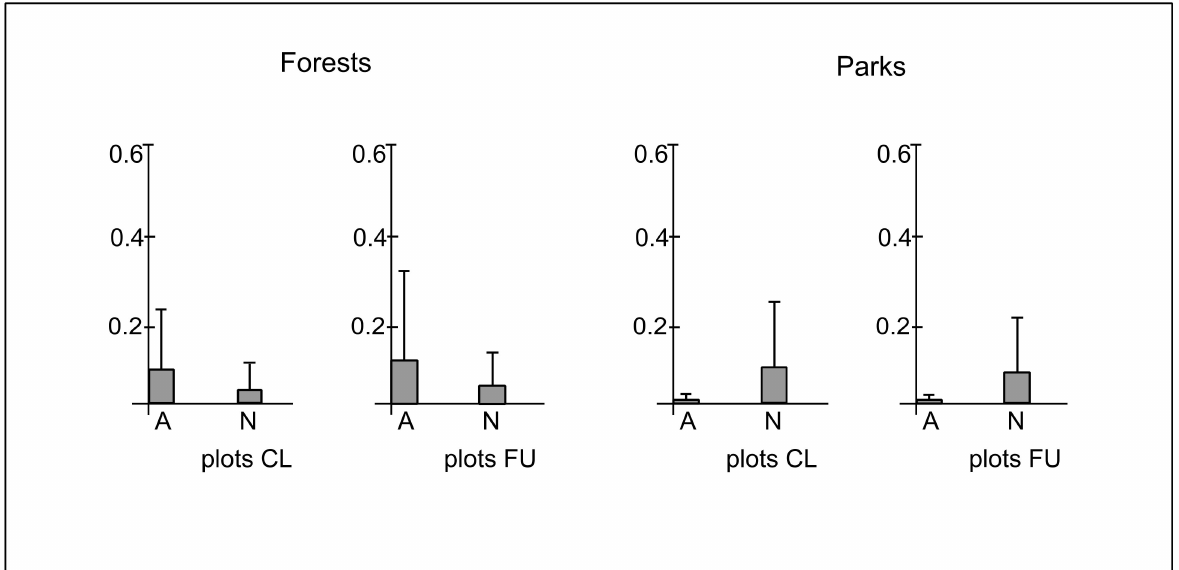
Figure 8. The mean (boxes) and standard deviation (whiskers) values of cover-abundance degree of alien (A) and native species (N) per plot in closer (CL) and further (FU) plots located along paths in forests and